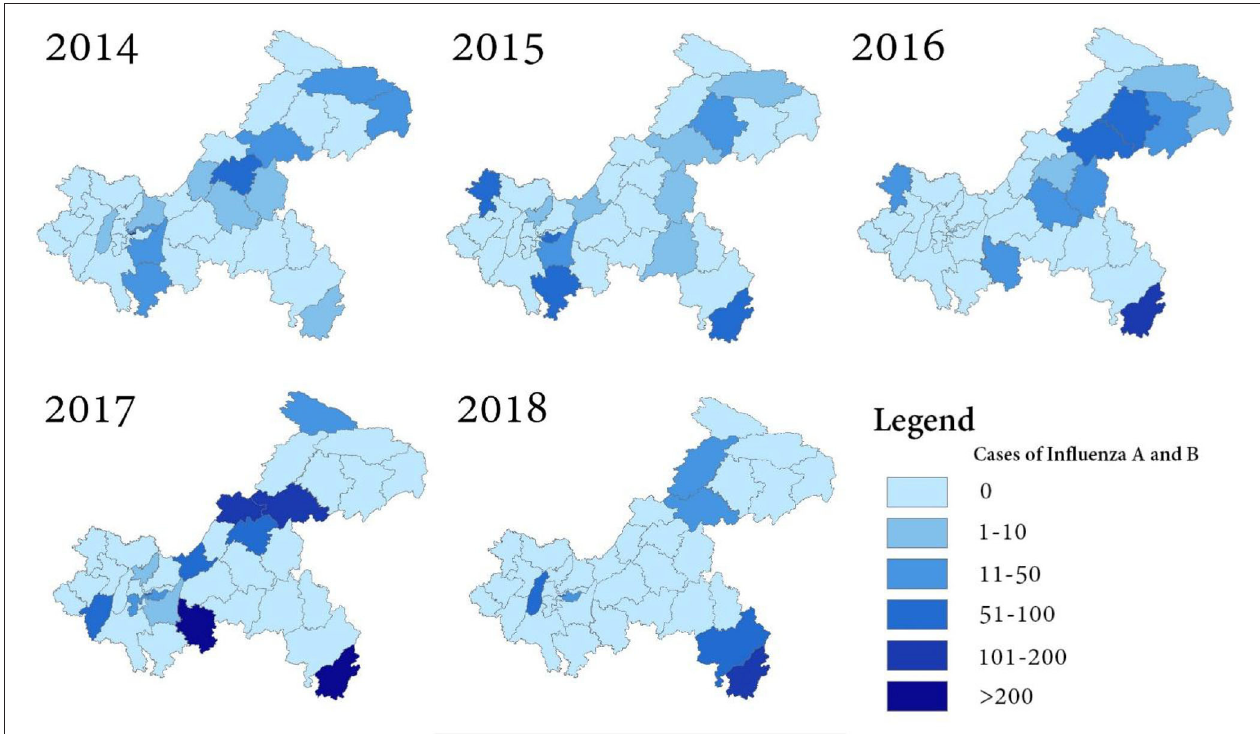
FIGURE 4 | Spatial distribution of influenza A and